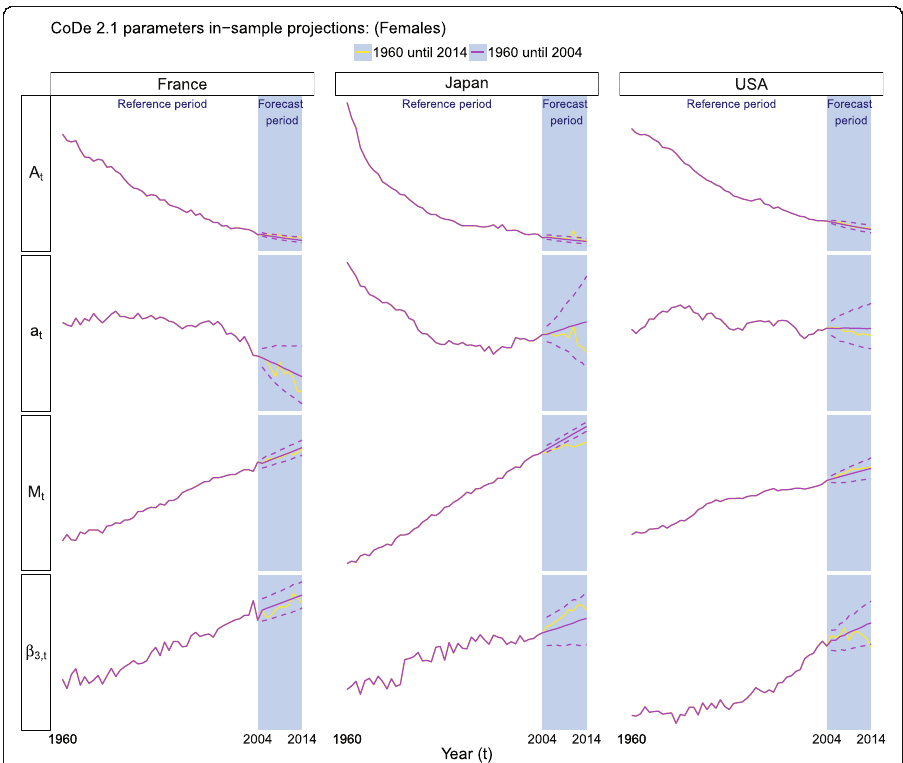
Fig. 13 Estimation and in-sample projections of CoDe 2.1 model parameters of females. The reference period is 1960 – 2004 (white); the projection period is 2005 – 2014